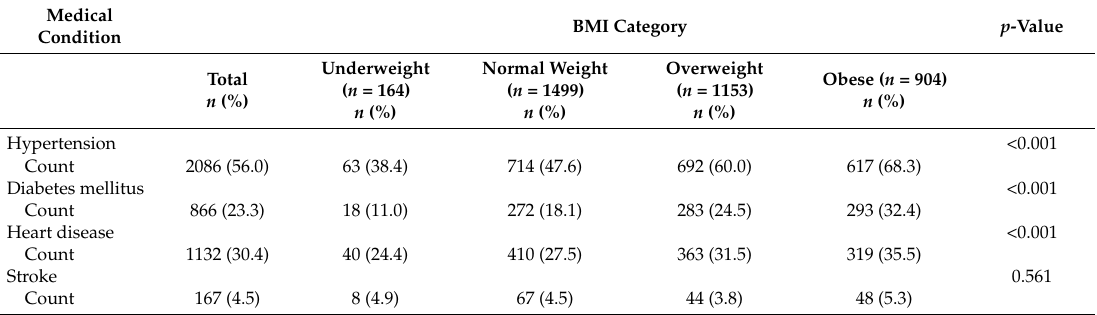
Table 2. Medical Conditions of Participants by Body Mass Index Category (Total n =